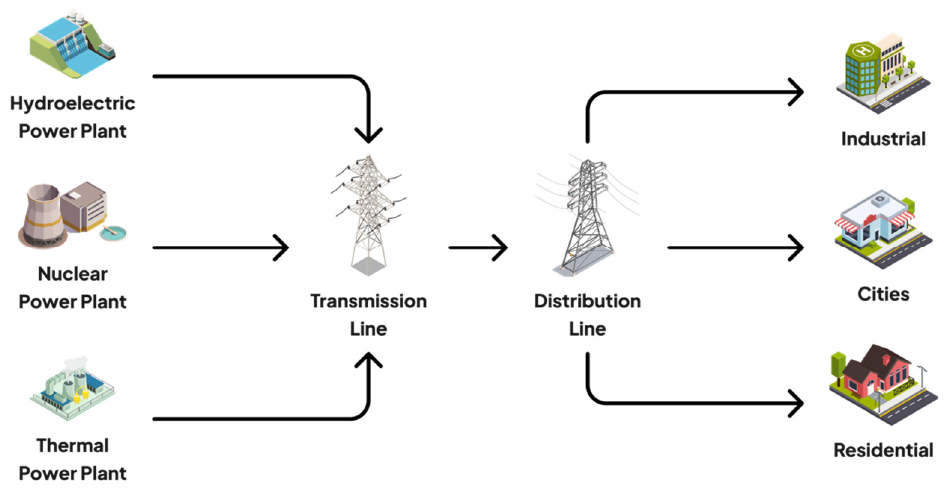
Figure 1. Traditional grid systems.